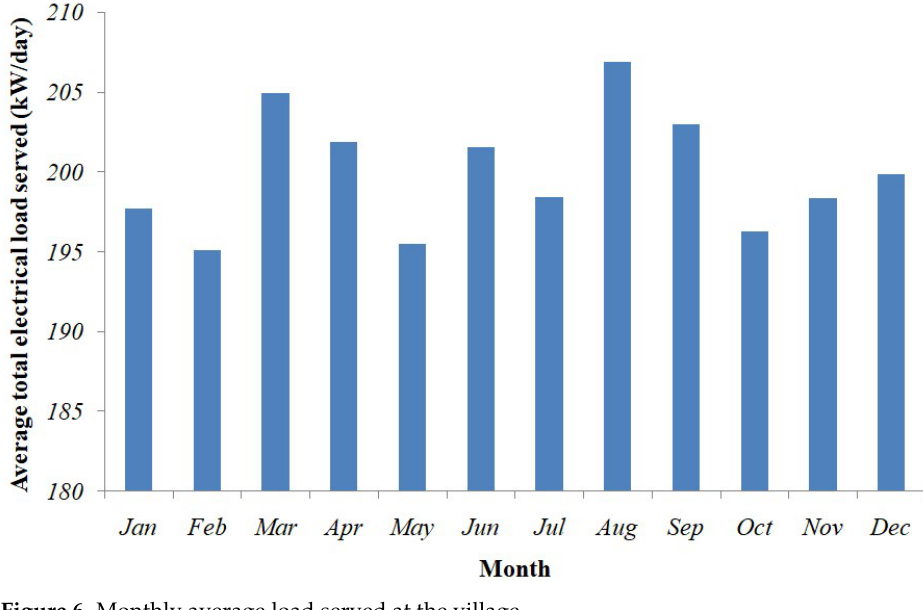
Figure 6. Monthly average load served at the village.